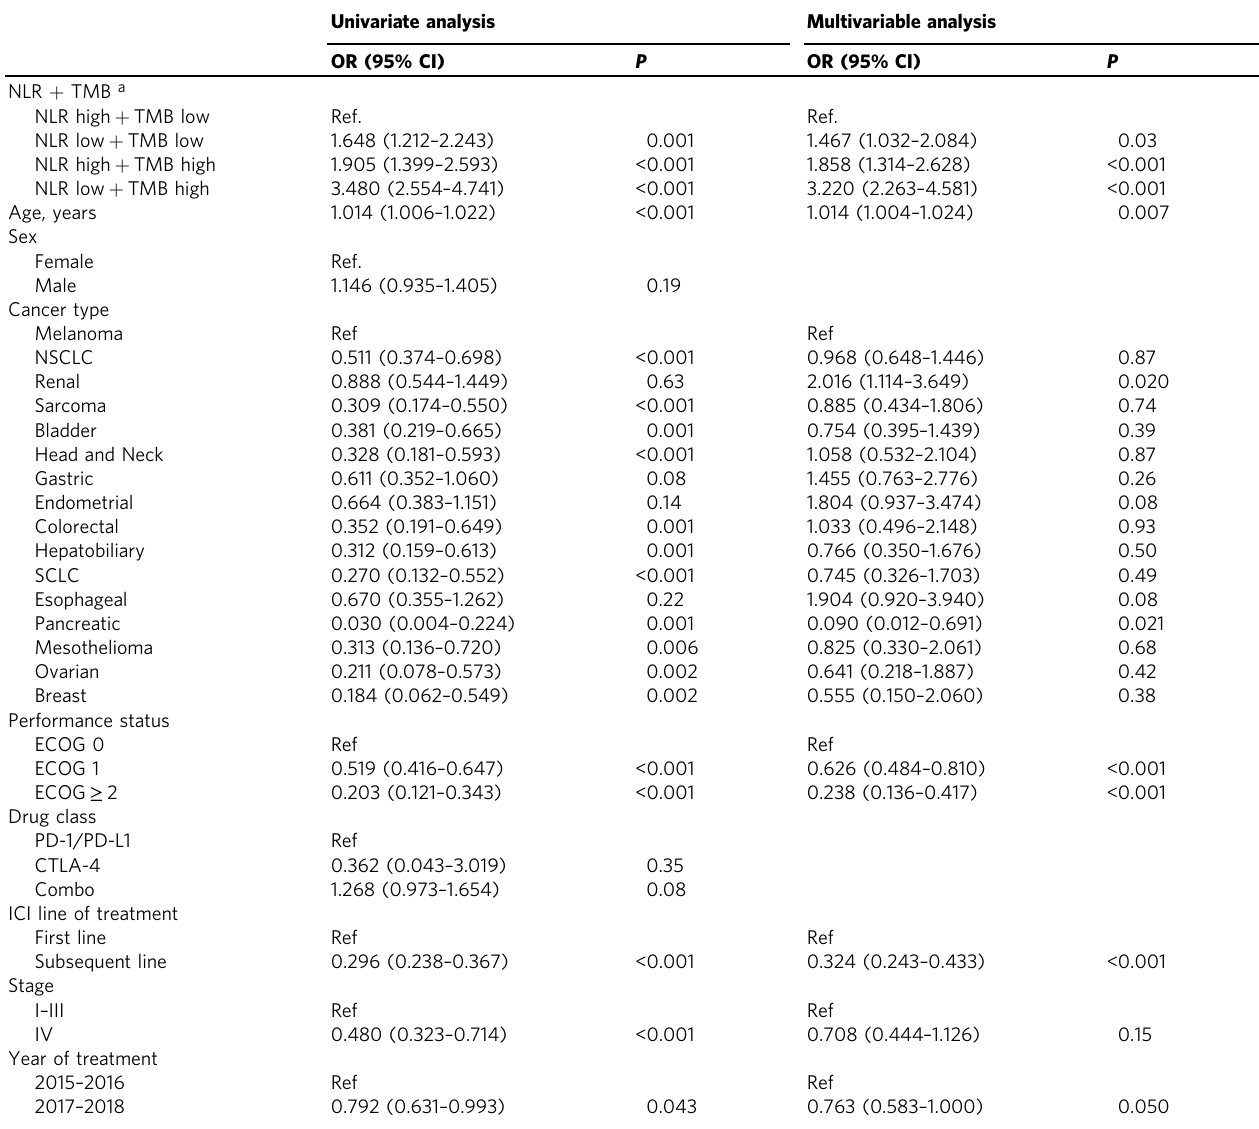
Table 1 Factors associated with clinical bene fi t from treatment with immune checkpoint inhibitors